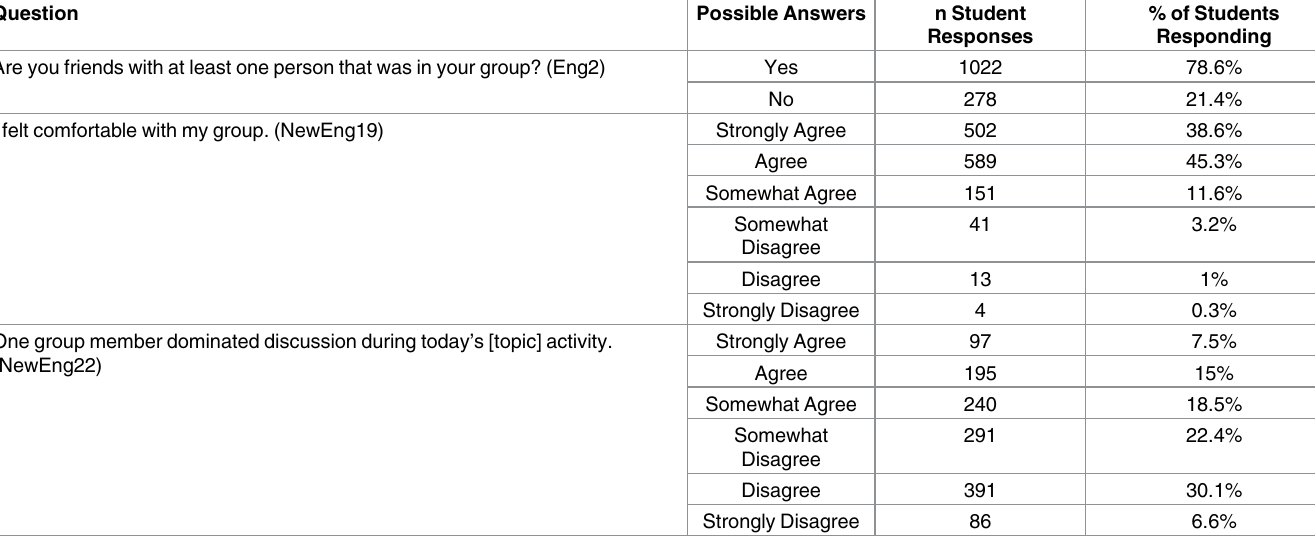
Table 1. Questions on the survey and the percentage of responses. Results are aggregatedacross all three iterations of the survey, so students’ views are repeated. Question